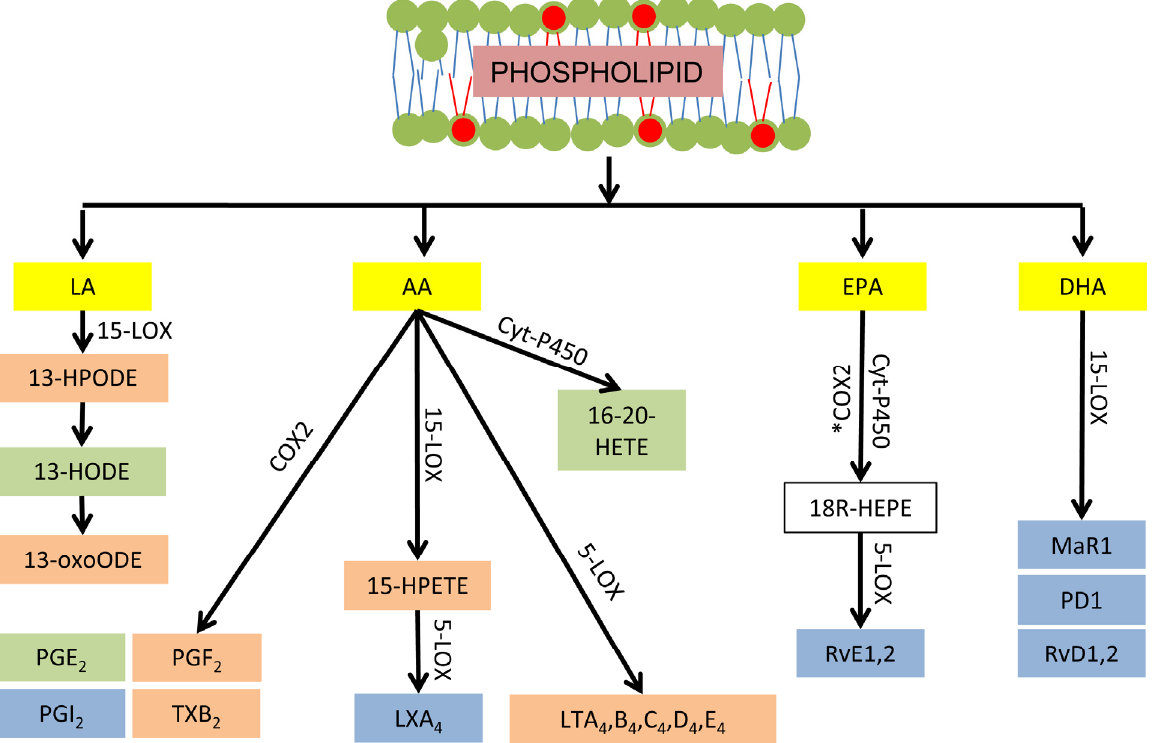
Figure 2. Fatty acyl chains of phospholipids located within the membranes of cells and organelles may be enzymatically oxidized into lipid mediators. Examples of proinflammatory ( orange ), resolving ( blue ), and variable function ( green ) lipid mediators are illustrated by fatty acid substrate ( yellow ) and biosynthetic enzyme. *: aspirin acetylated; LA: linoleic